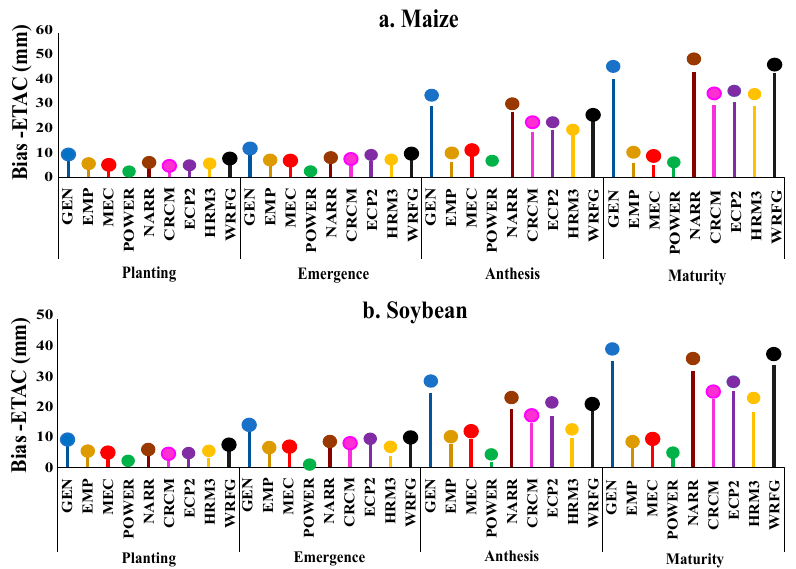
Figure 8. Root mean squared error (RMSE, colored circles) and mean error (ME, colored bars) of accumulated crop evaporation (ETAC) for the different sources of estimated solar radiation at the start date of planting, emergence, anthesis, and maturity for maize ( a ) and soybean ( b ). See Figure 2 for definition of abbreviations.